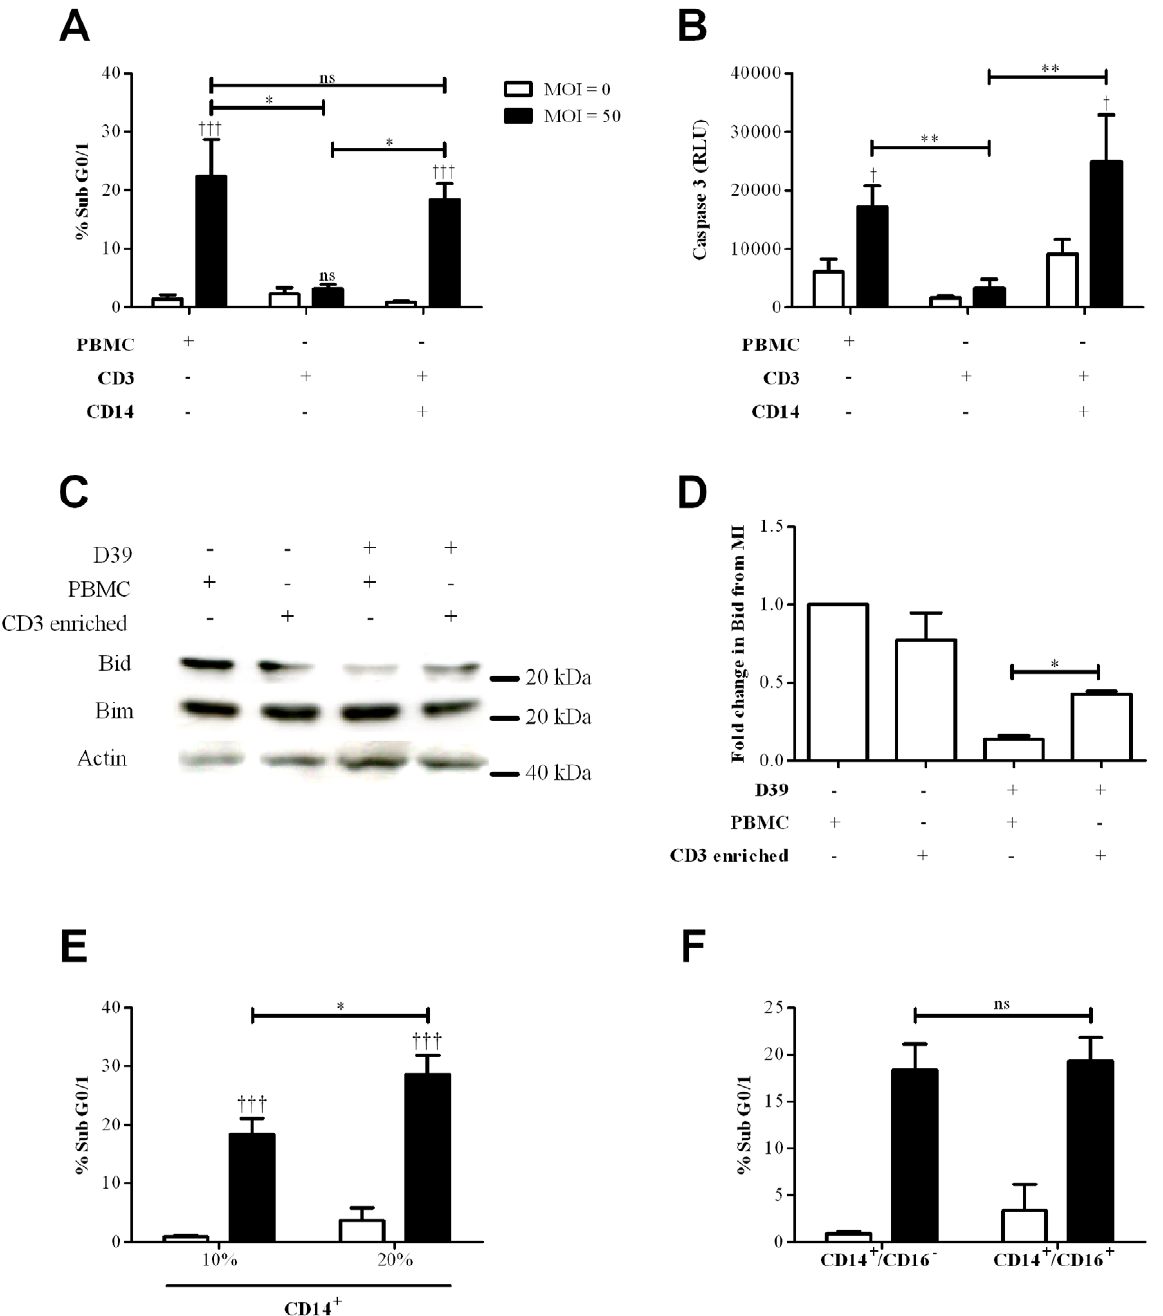
Figure 3. CD14 + monocytes reconstitute apoptosis in CD3 + T-cells following Streptococcus pneumoniae challenge. A) Peripheral blood mononuclear cells (PBMC), purified CD3 + T-cells (CD3 + CD14 2 ) or co-cultures of purified CD3 + T-cells with 10% purified CD14 + monocytes (CD3 + CD14 + ) were mock-infected (MOI=0, white bars) or challenged with D39 Streptococcus pneumoniae (MOI=50, black bars) for 16 h and accumulation of hypodiploid DNA (% Sub G0/1) measured in CD3 + T-cells, n=4. B) caspase 3 activation in CD3 + T-cells under the same condition as A), n=4. C) Representativewesternblot probed for Bid, BimandactinfromCD3 + T-cells isolated fromPBMCorCD3enrichedcultures followingbacterialchallengeas in A), D) densitometry summarizes the fold change in Bid compared to the mock infected (MI), derived from three separate experiments. E) % Sub G0/1 purified CD3 + T-cells in co-cultures containing 10% or 20% of purified CD14 + monocytes under the same conditions as A), n=4 or in F) co-cultures of CD3 + T-cells and purified CD14 + monocytes with (CD14 + /CD16 2 ) or without (CD14 + /CD16 + ) CD16 + monocyte depletion, under the same conditions as A), n=4, ns (not significant) * p , 0.05, ** p , 0.01, *** p , 0.001; statistical analysis by ANOVA.